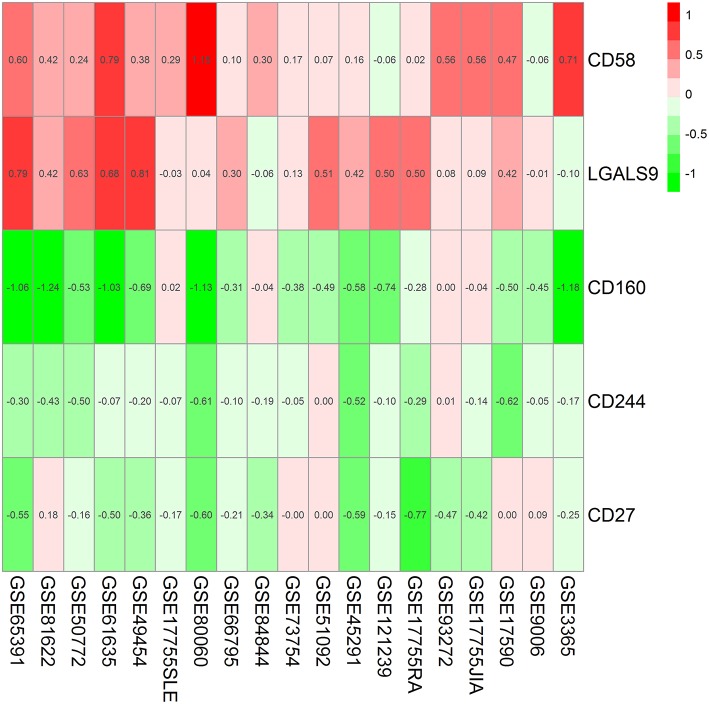
Heatmap shows those significant genes in the RRA analysis of 19 array datasets. Data from 19 array datasets were integrated using RRA method. CD160 was the most significant down-regulated gene in autoimmune diseases (Adjusted P = 5.9E-12), while CD58 was the most significant up-regulated gene (Adjusted P = 5.7E-06). The numbers in the heatmap were for the logarithmic fold change in each dataset which was calculated by the limma package. Red indicated increased expression, and green indicated decreased expression.